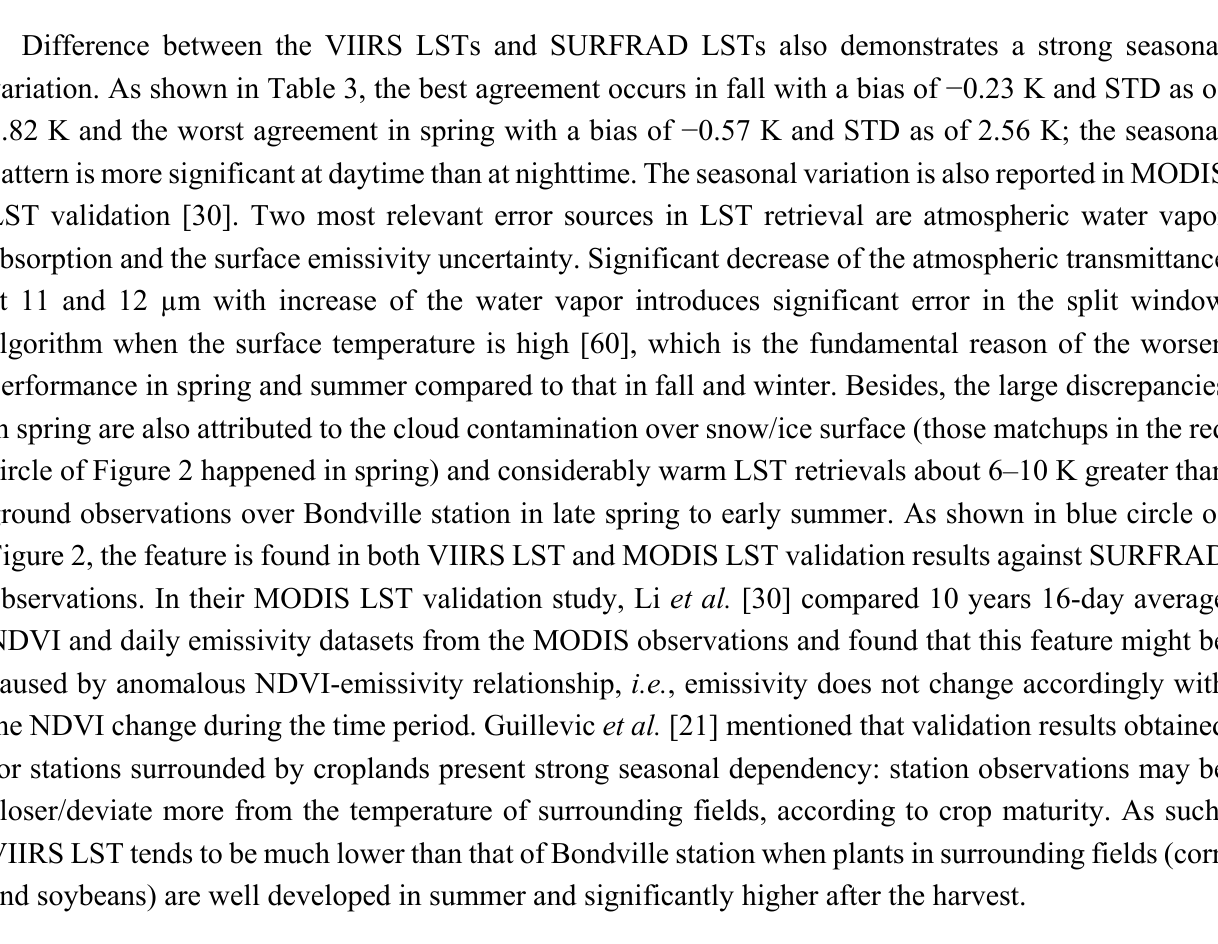
Table 3. Seasonal variation from the validation using SURFRAD